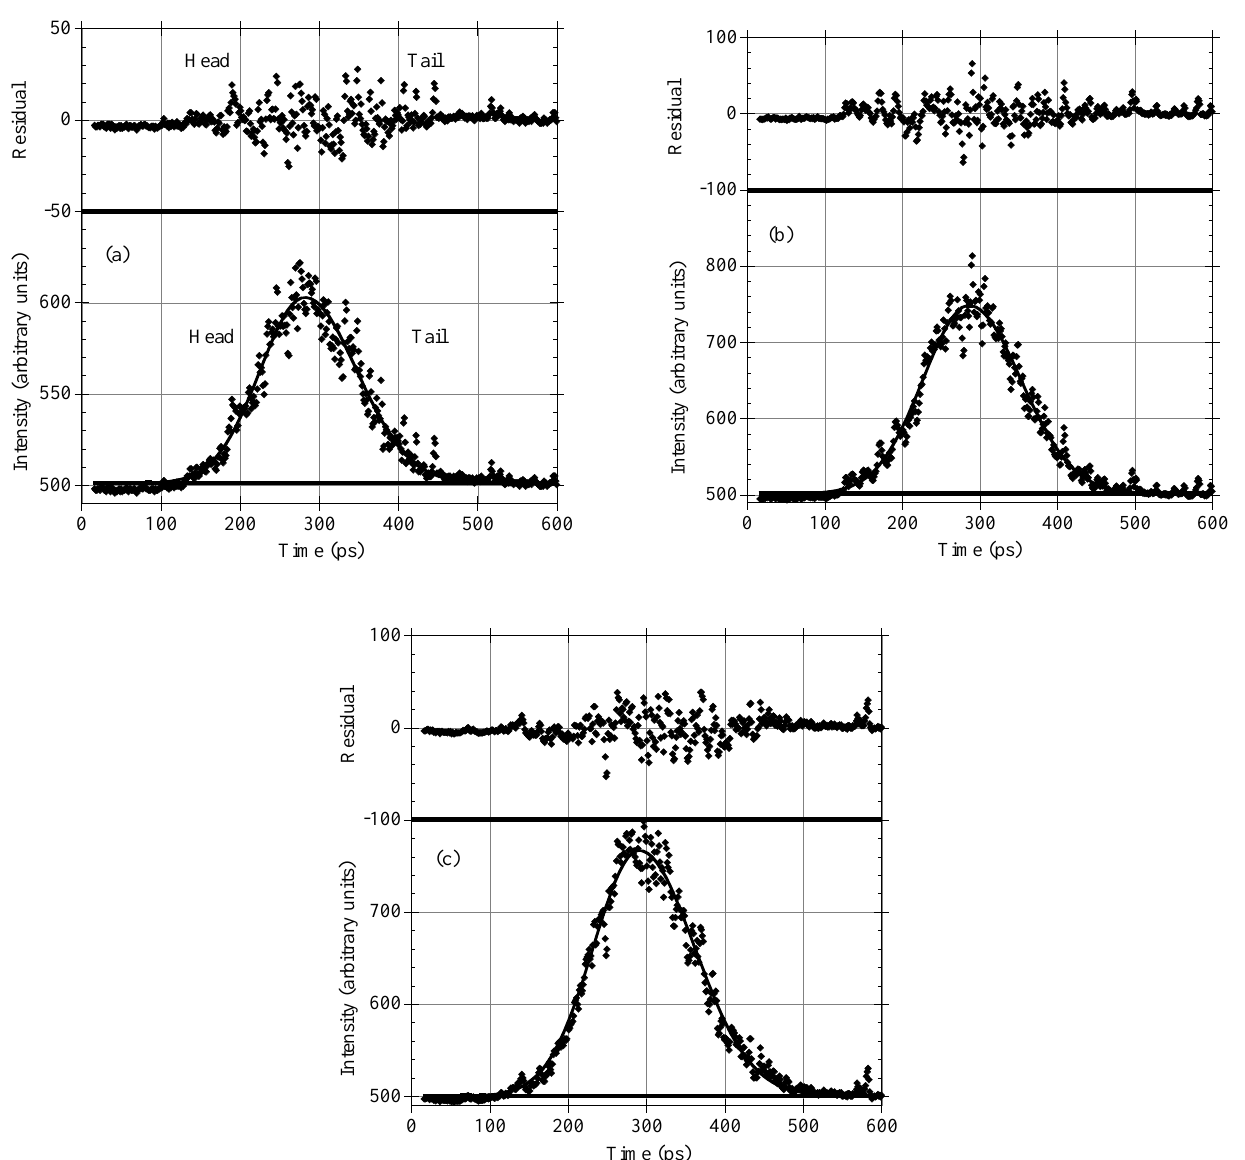
FIG. 7. A single data acquisition of the electron longitudinal bunch distribution fit to the mean distribution with the rms width and asymmetry factor kept constant. The residual from the distribution is plotted above the distribution for the current for the settings of (a) 1.3 mA per bunch, (b) 6.0 mA per bunch, and (c) 12.5 mA per